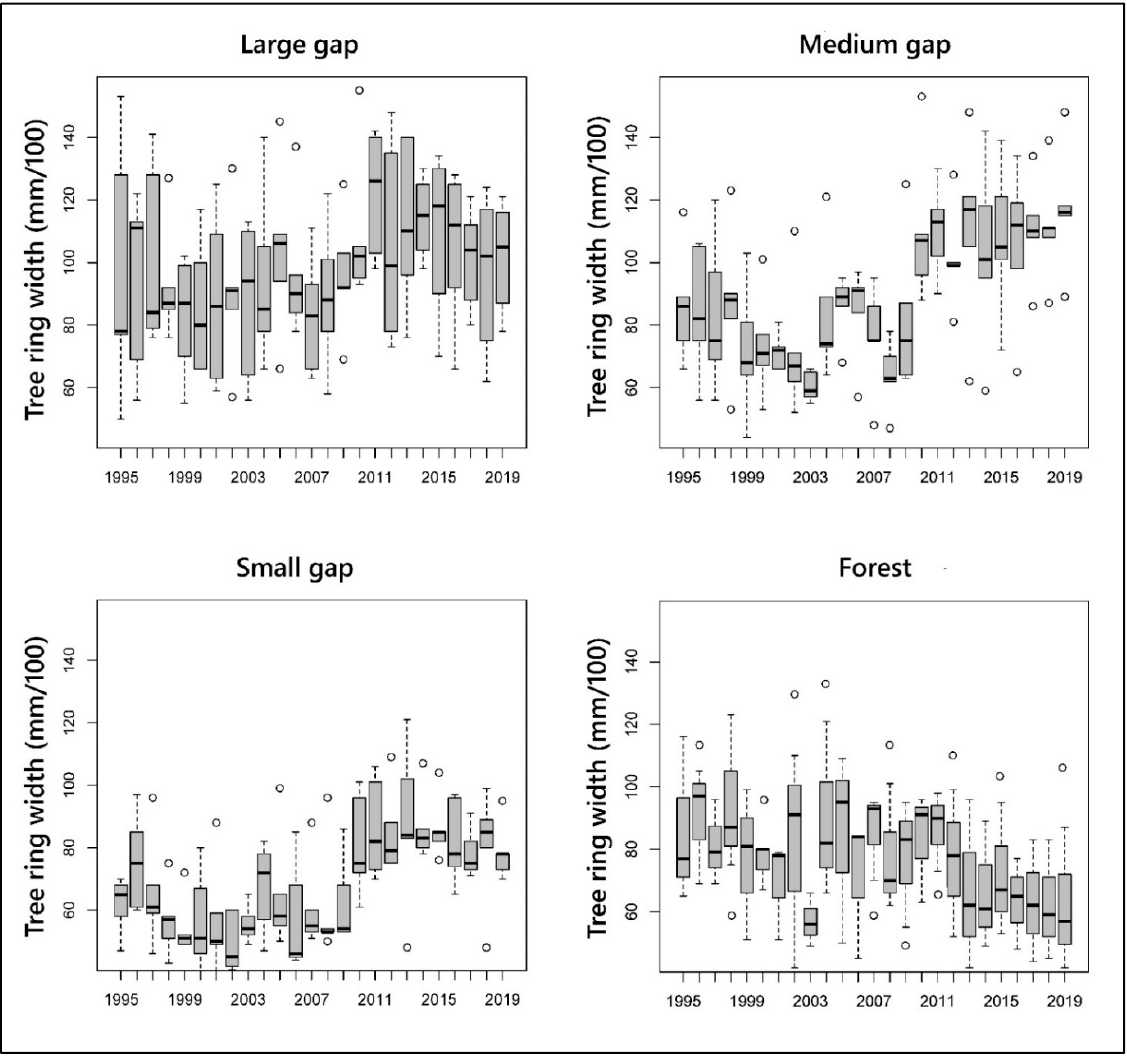
Figure 6. Variability and median values of ring width related to tree sampled in each gap (large medium and small) and in forest. The box plots explanations are as in Figure 2, with the difference of the median values represented here by the heavy horizontal line. The values are expressed in 100th of a millimeter (mm/100).